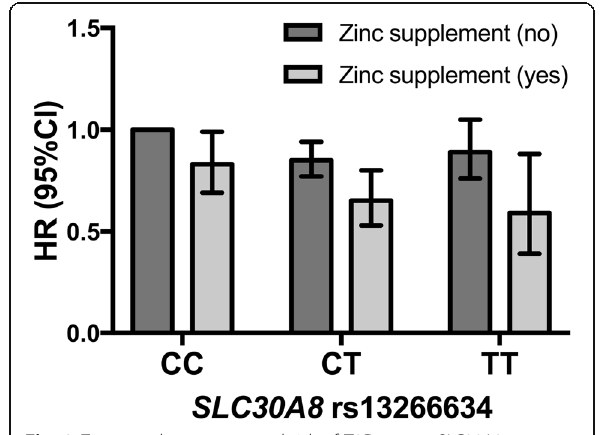
Fig. 4 SLC30A8 rs13266634 genotype and risk of T2D across categories of BMI in the MDCS ( n = 20,929). Hazard ratios (HR) from a Cox proportional hazards model with attained age as the time scale with adjustment for non-dietary confounders, total energy intake, and diet supplement use (any). P interaction (genotype × BMI) = 0.007